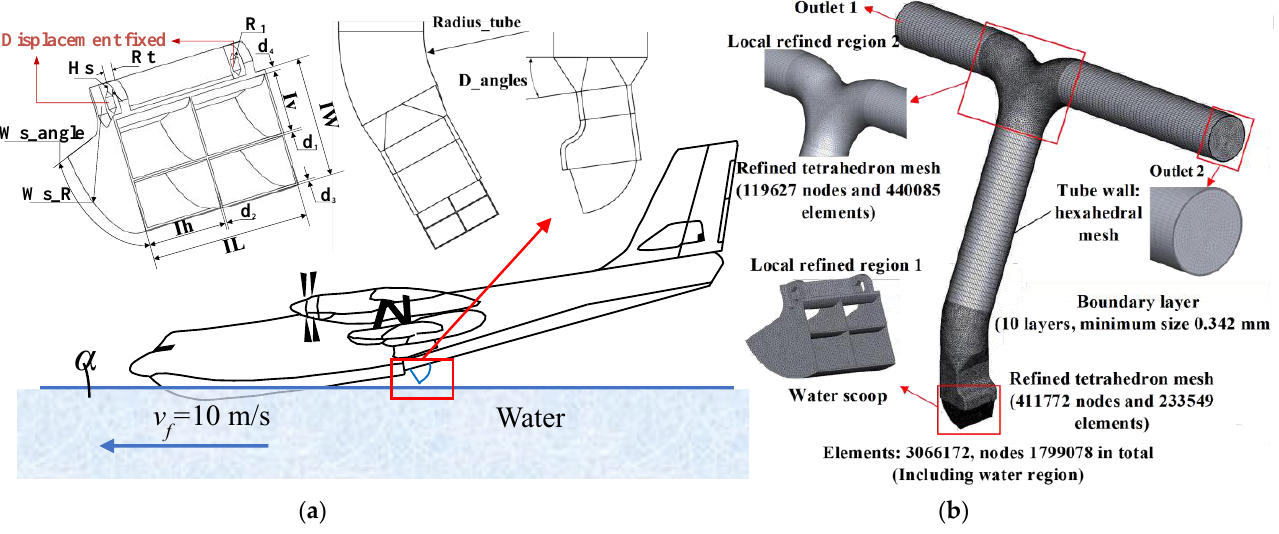
Figure 6. The schematic graph of scooping system in amphibious aircraft. ( a ) Structure; ( b ) Mesh. Table 3. Parameters, design variables and objectives involved in optimization.